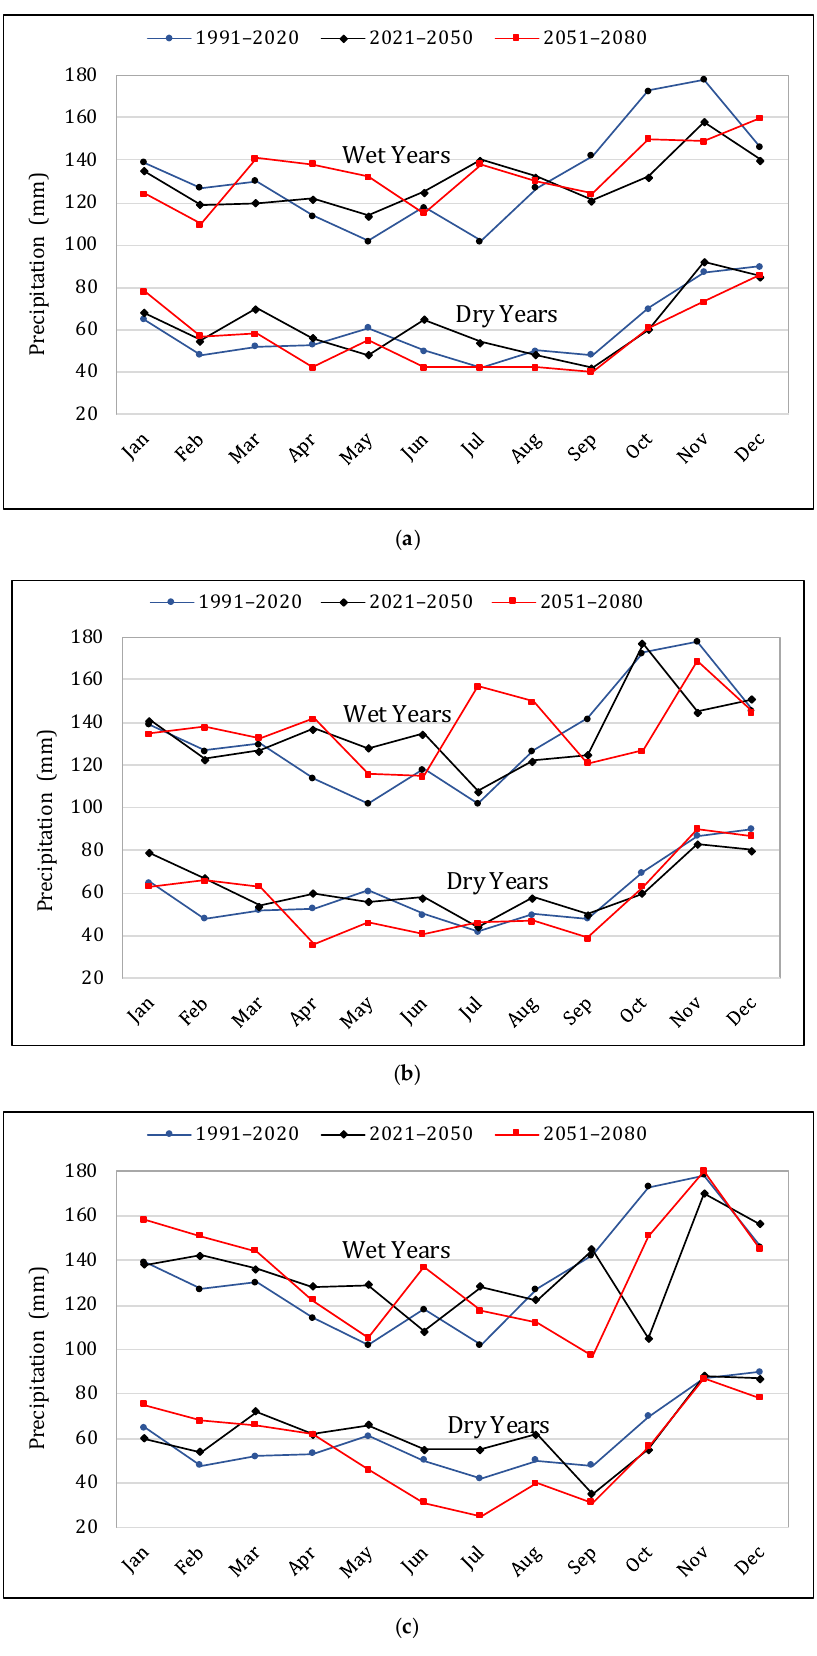
Figure 5. Expected monthly precipitations during wet (PoE = 20%), and dry years (PoE = 80%) under RCP2.6 ( a ), RCP4.5 ( b ), and RCP8.5 ( c ) scenarios at in the eastern zone (Alliston).